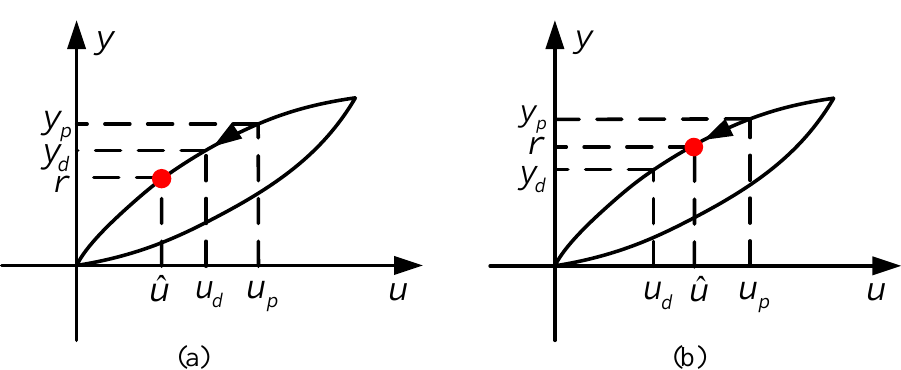
Figure 7. The change of desired output displacement as system input decreases, including ( a ) the current output displacement is greater than the desired output displacement and ( b ) the current output displacement is less than the desired output displacement for the first